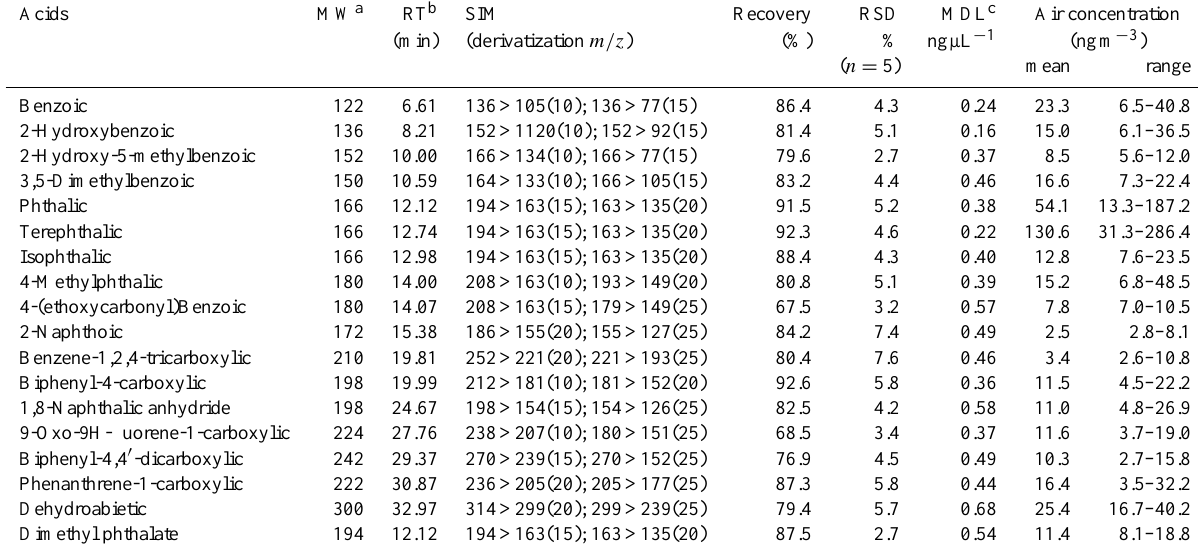
Table 2. Parameters used to determine AMAs, dimethyl phthalate, and the concentrations found in samples collected in January 2013,